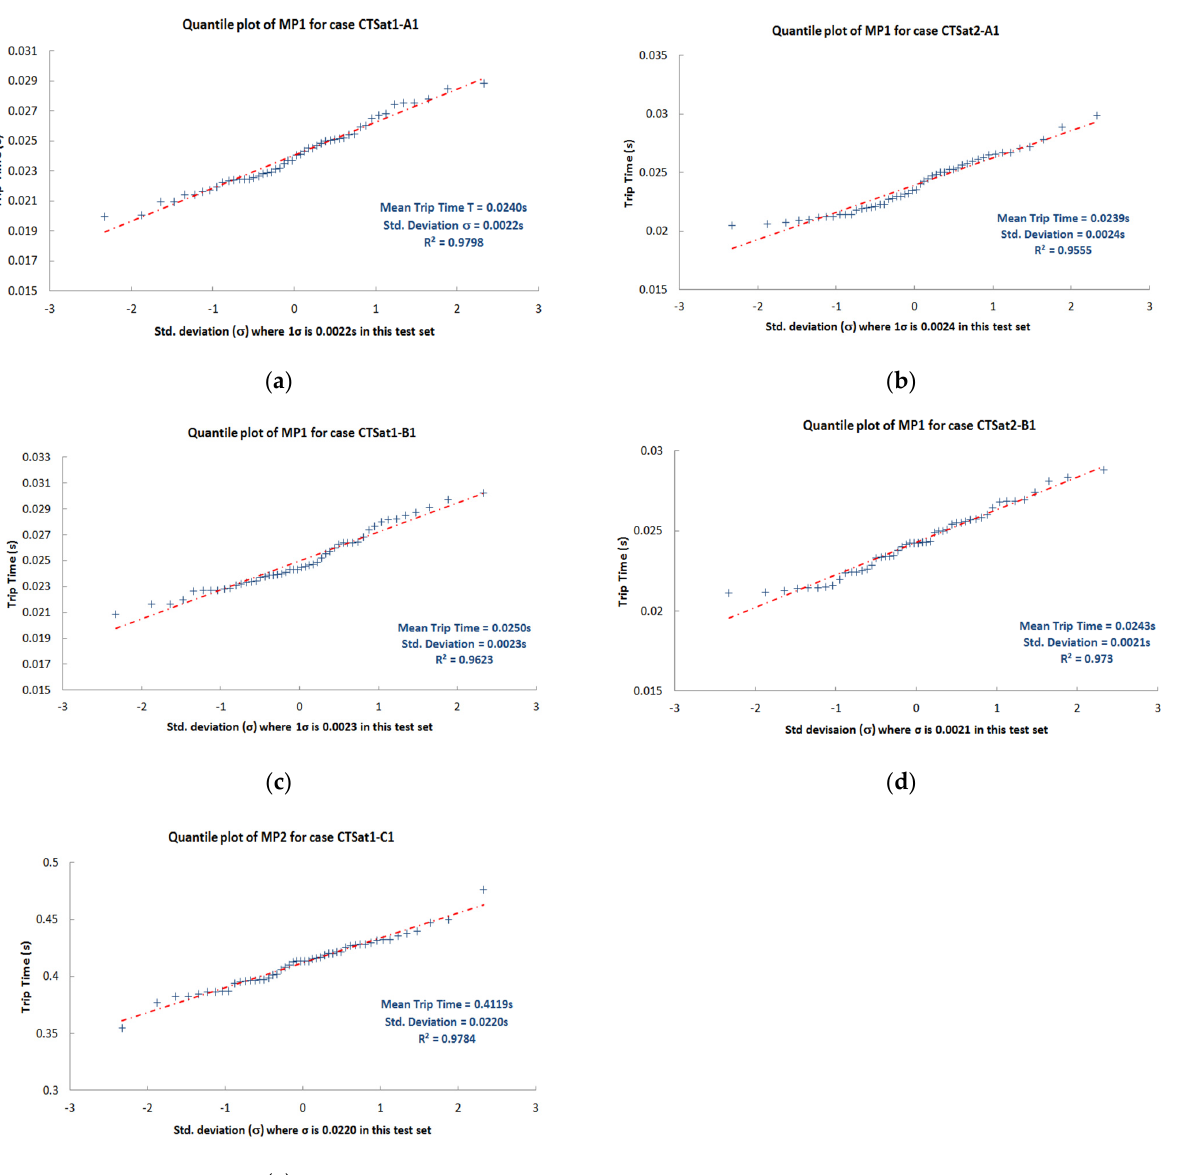
Figure 18. Quantile plot for cases: ( a ) MP1 CTSat1-A1 (light CT saturation, no faulty components, 3Ph-G fault at 50% of the feeder); ( b ) MP1 CTSat2-A1 (deep CT saturation, no faulty components, 3Ph-G fault at 50% of the feeder); ( c ) MP1 CTSat1-B1 (light CT saturation, 1 faulty fibre, 3Ph-G fault at 50% of the feeder); ( d ) MP1 CTSat2-B1 (deep CT saturation, 1 faulty fibre, 3Ph-G fault at 50% of the feeder); and ( e ) MP2 CTSat1-C1 (light CT saturation, 1 faulty AMU, 3Ph-G fault at 50% of the